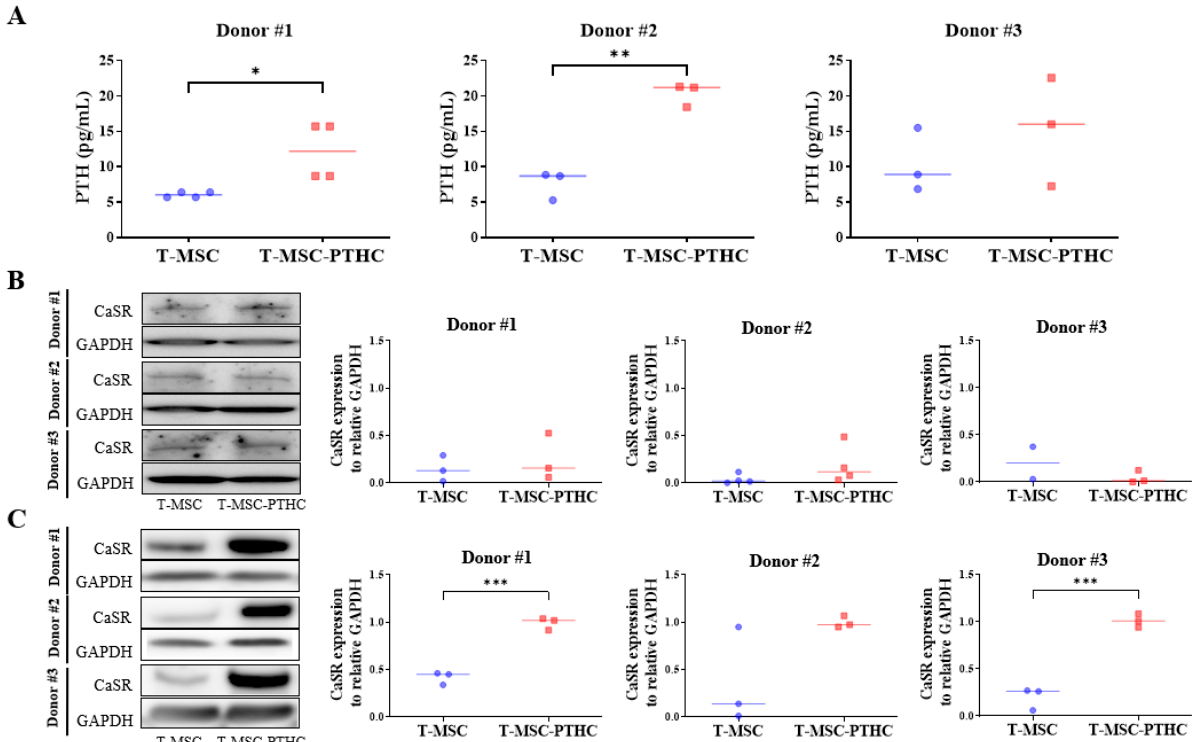
Figure 2. Establishment of the PTH-secretion potential of T-MSC-PTHCs from three donors: ( A ) conditioned medium was taken each step of T-MSC and T-MSC-PTHCs, and the concentration of PTH was measured using a commercial PTH ELISA kit at high cell density. Data are presented as the mean ± SD of at least three experiments (* p < 0.05, ** p < 0.01). PTH concentrations were significantly increased in T-MSC-PTHCs, compared with T-MSCs derived from donors #1 and #2, respectively. The expression of CaSR protein during differentiation of T-MSCs into T-MSC-PTHCs was measured by Western blotting and quantified using ImageJ software at low ( B ) and high ( C ) cell densities. Protein levels are normalized to GAPDH. Data are presented as the mean ± SD of at least three experiments (*** p < 0.001). CaSR expression levels were significantly increased in T-MSC-PTHCs, compared with T-MSCs derived from donors #1 and #3, respectively. Abbreviations: PTH, parathyroid hormone; T-MSC, tonsil-derived mesenchymal stem cells; T-MSC-PTHCs,